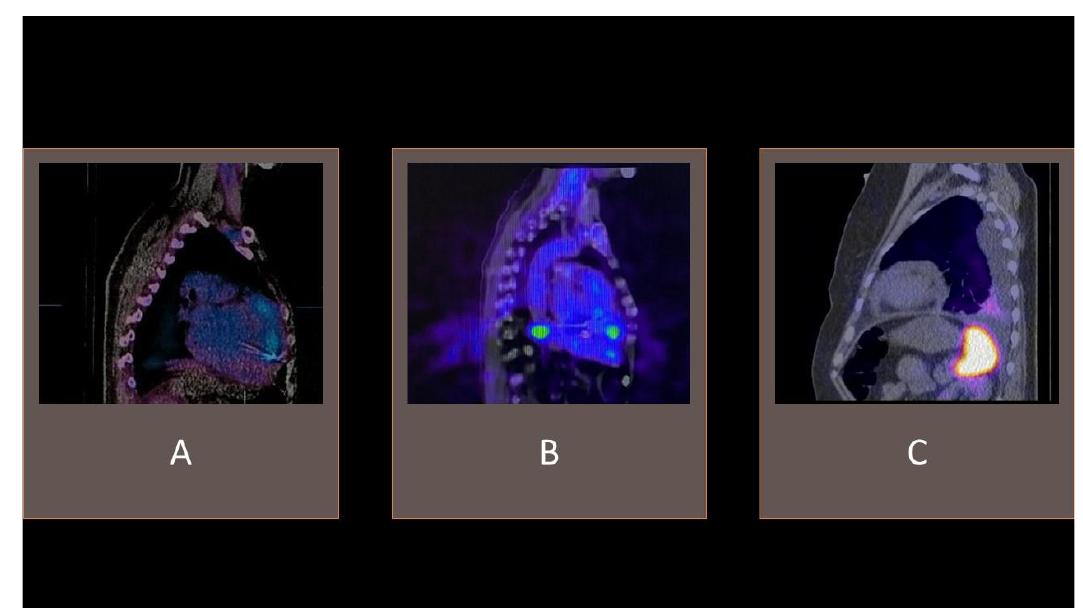
Figure 4. Examples of 99m Tc-HMPAO-SPECT/CT. ( A ) tracer uptake consistent with cardiac device- related infective endocarditis with an accumulation of radiolabeled leucocytes in the vicinity of an implanted electrode. ( B ) visible tracer uptake in the vicinity of an implanted left ventricle assist device. ( C ) accumulation of radiolabeled leucocytes in the pleural cavity effusion, without patho- logical intracardiac uptake.